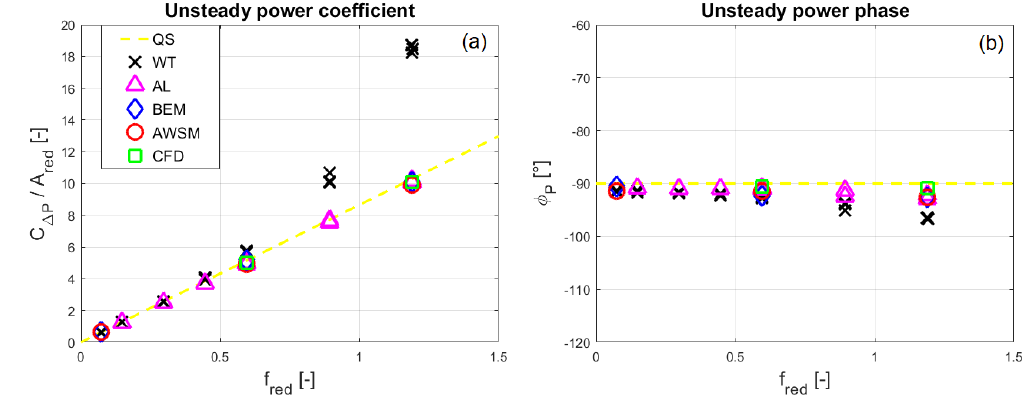
Figure 10. Unsteady power coefficient comparison (a) , comparison of the phase of the surge harmonic of the power oscillation (b) .